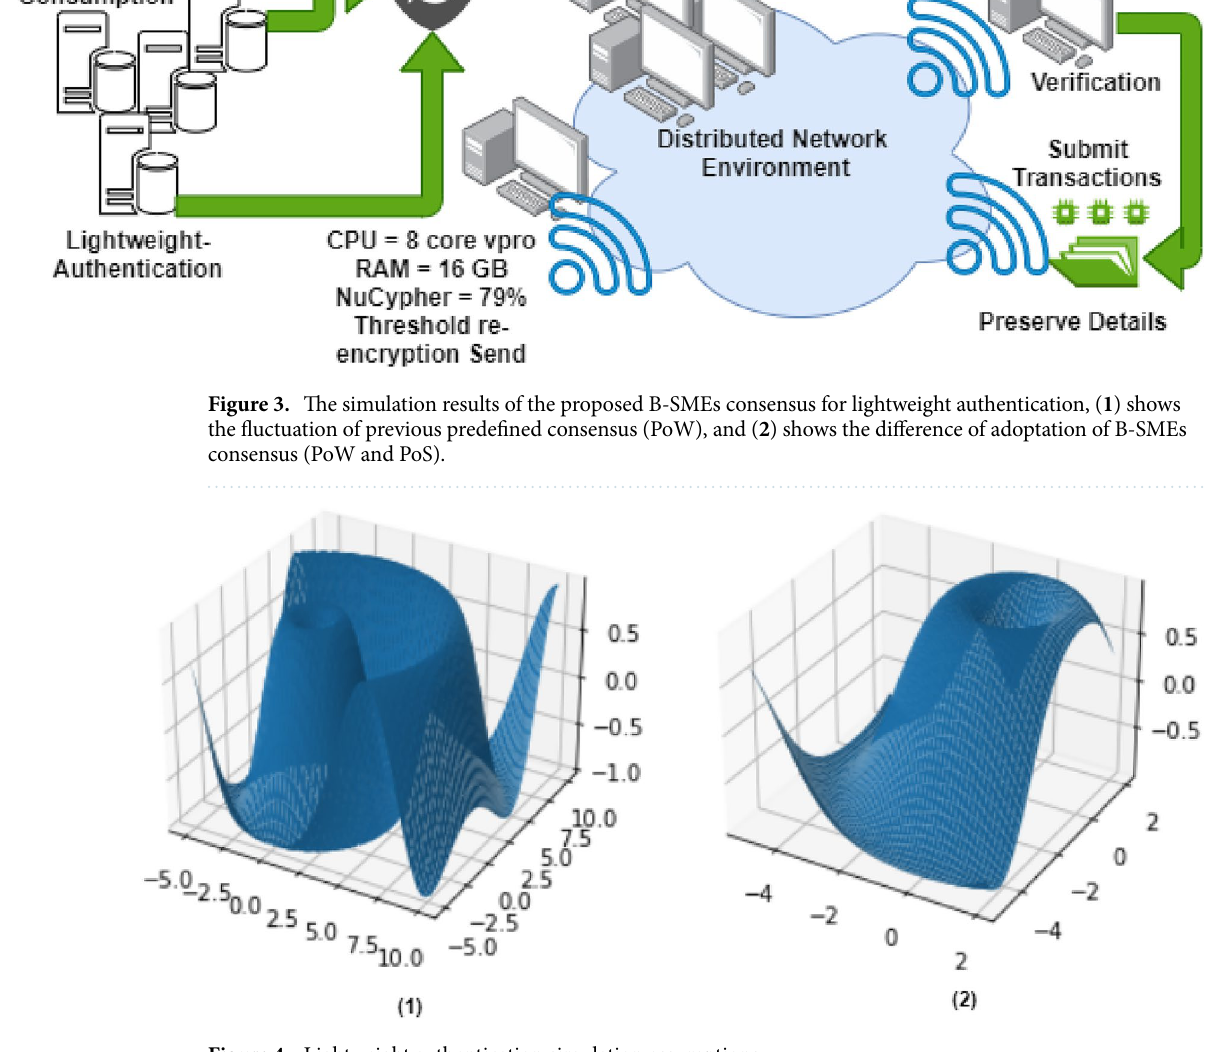
Figure 4. Lightweight authentication simulation